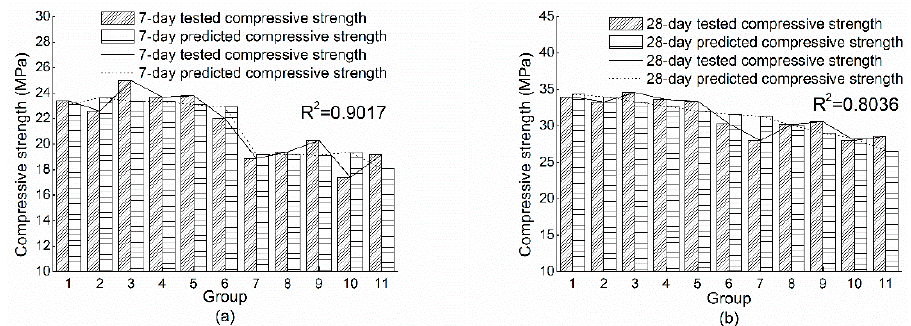
Figure 2. Comparison of tested and predicted compressive strength of concrete at the age of ( a ) 7 days and ( b ) 28 days.